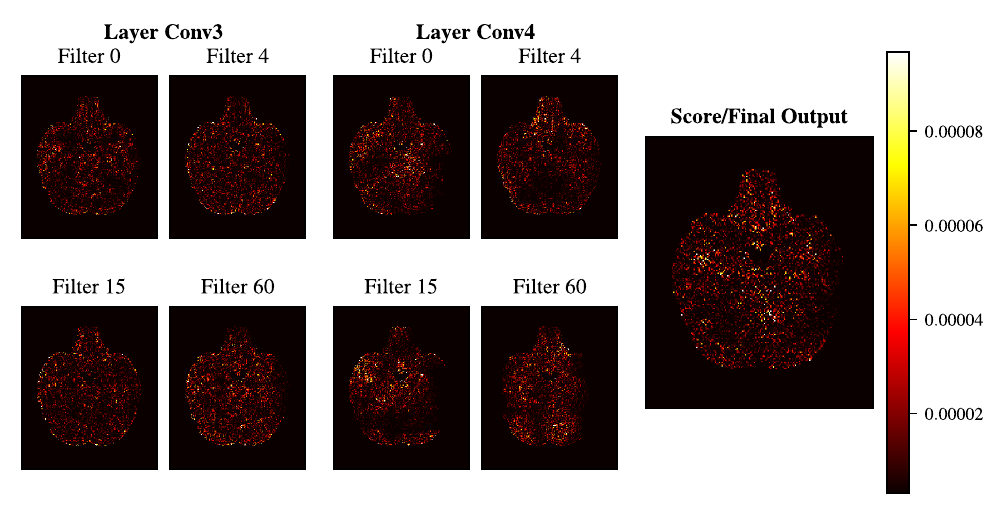
Figure 8. Heatmaps of the baseline trained on the big UK Biobank data set generated from the last two convolutional layers and the final output. Four filters from the convolutional layers were randomly selected. Note that there is no special relationship between the filters at the same location (i.e. filter 0 at conv 3 and conv 4) as each filter is applied to all previous feature